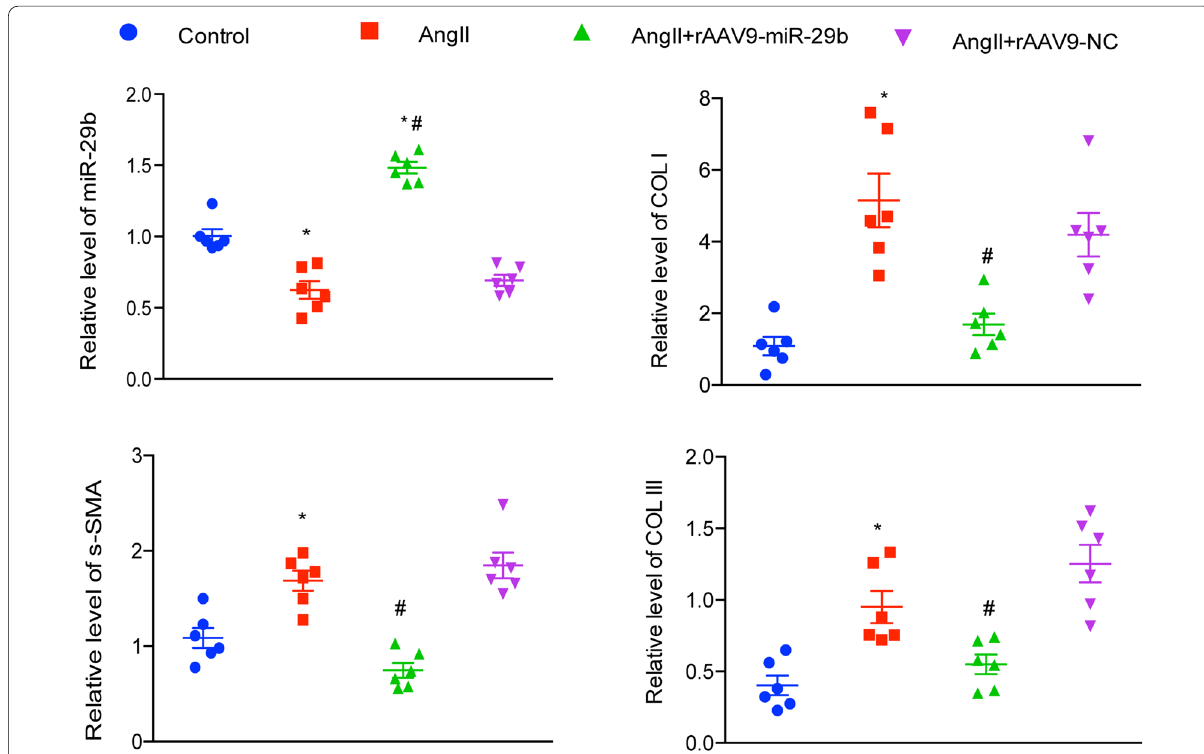
Fig. 4 Effect of rAAV9‑miR‑29b delivery on fibrotic markers in kidney. Mature miR‑29b levels was significantly increased in rAAV9‑miR‑29b transduction group. The expression levels of alpha‑smooth muscle actin (a‑SMA), collagen type I (COL I) and collagen type III (COL III) were evaluated as fold change relative to the control animals at 5 weeks post gene transfer. Values represent mean differences: * P < 0.05, rAAV9‑miR‑29b vs. control group, # P < 0.05, AngII adeno‑associated vector type 9; NC, negative